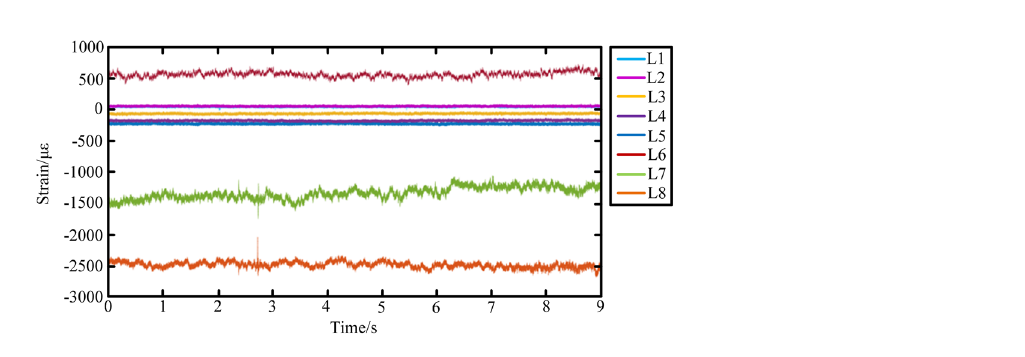
Figure 14. The strain law of the coal and rock at different